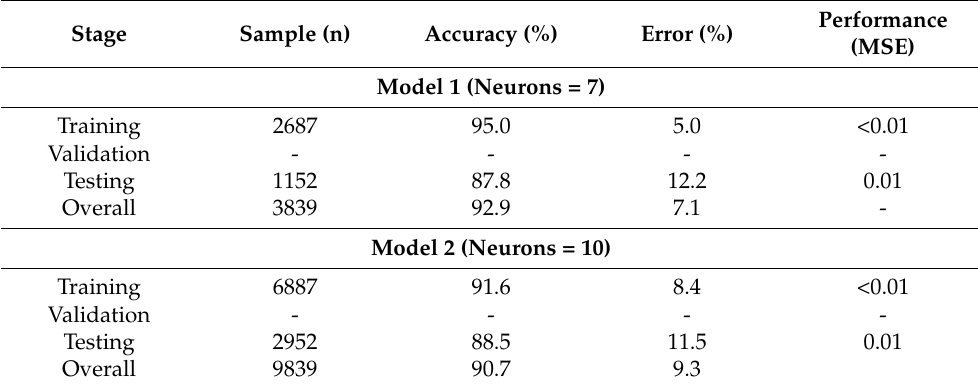
Table 4. Statistical results of the ANN model using Bayesian Regularization algorithm of the artificial neural network.